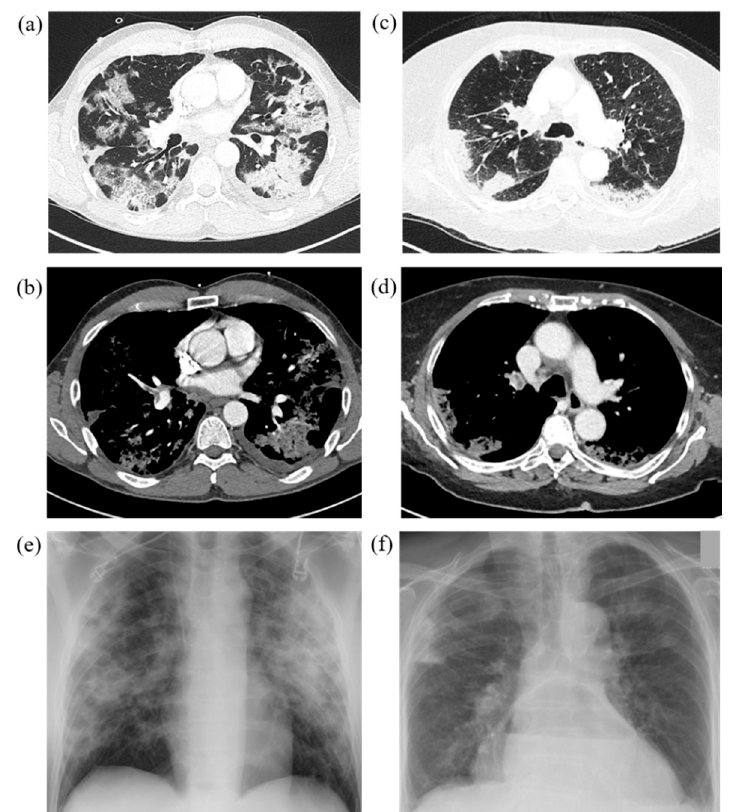
Figure 3. Representative cases with typical COVID-19 findings on chest CT and chest radiograph in both study groups. IV = Invasive ventilation group; non-IV = No/non-invasive ventilation group. ( a )/( b ) Chest CT of a 49-year-old, PCR-confirmed male COVID-19 patient in the IV-group after onset